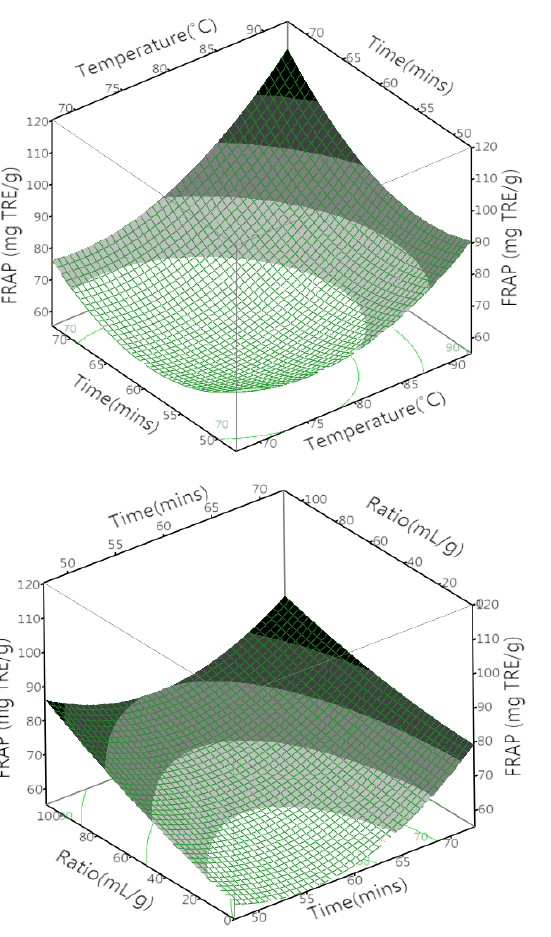
Figure 4. 3D response surface and 2D contour plots for the effects of the test parameters on antioxidant